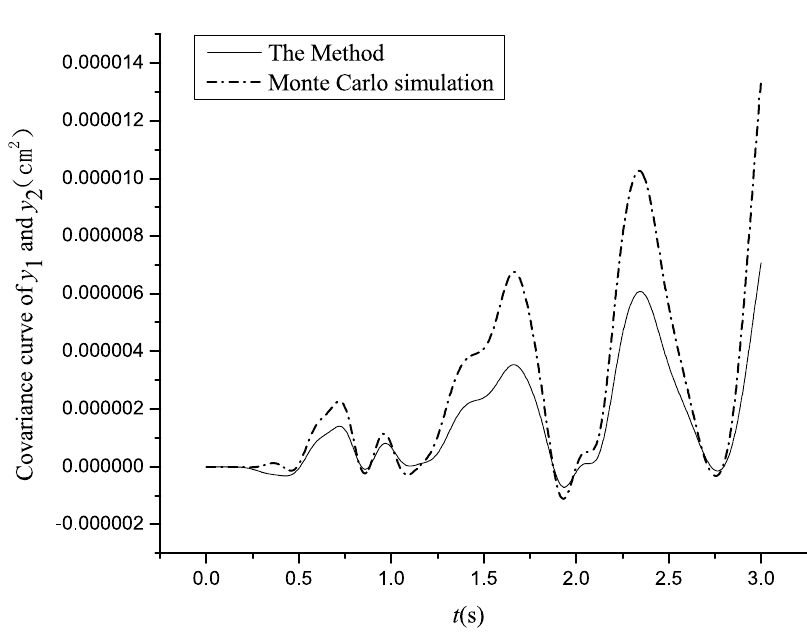
Fig. 6. The covariance curve of the y 1 and y 2